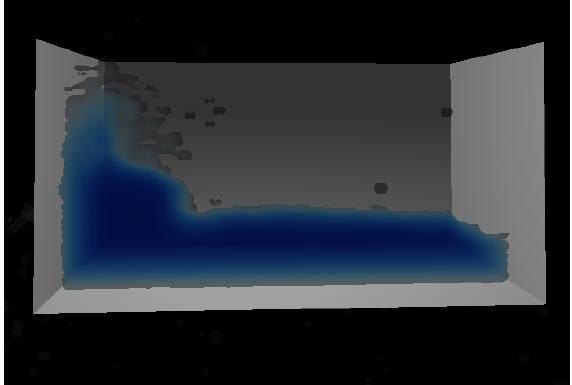
Fig. 19: Simulation state at 1 . 6